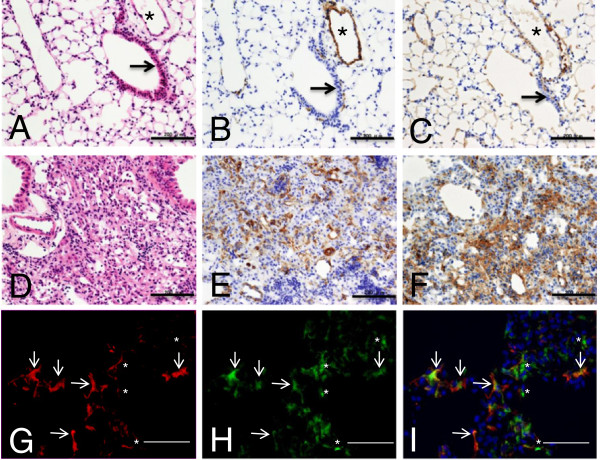
Myofibroblasts expressed type 1 collagen in bleomycin-injured lungs. Saline-treated lungs were fixed in formalin and examined by H & E stain (A) and using anti-α-SMA antibody (B) and anti-Col1A1 antibody (C). 12 days after bleomycin had been administered, bleomycin-injured lungs fixed in formalin were examined by H & E stain (D) and using anti-α-SMA antibody (E) and anti-Col1A1 antibody (F). Snap-frozen bleomycin-injured lungs at day 12 were fixed in cold acetone and examined by immunofluorescence using anti-α-SMA antibody (G) and anti-Col1A1 antibody (H), and these latter two images were merged with nuclear stain using DAPI (I). Asterisk and arrow indicate pulmonary and bronchial epithelium, respectively. In (G), (H), and (I), arrows indicate cells that were α-SMA- and Col1A1 double-positive. The asterisk indicates Col1A1 in the interstitial space. Figures show representative results. Scale bars in (A to F) indicate 200 μm. Scale bars in (G to I) indicate 100 μm. α-SMA, α-smooth muscle actin; Col1A1, collagen 1A1, DAPI, 4´,6-diamidino-2-phenylindole.